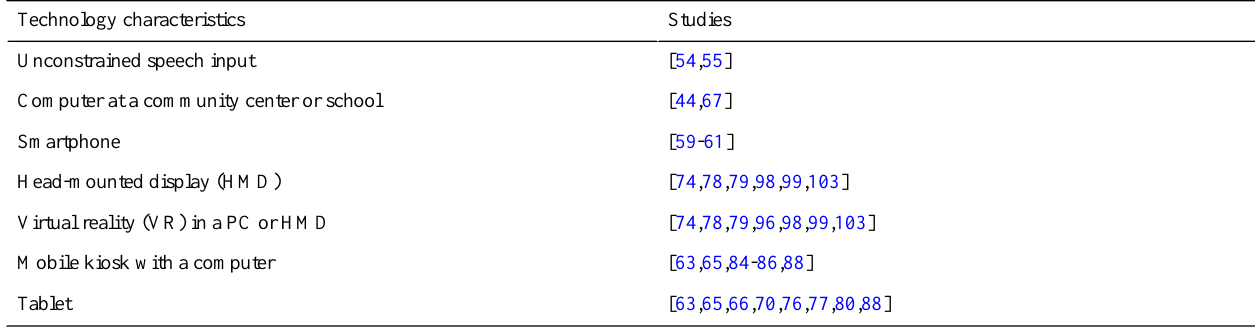
Table 2. Technology characteristics identified in the eligible studies.